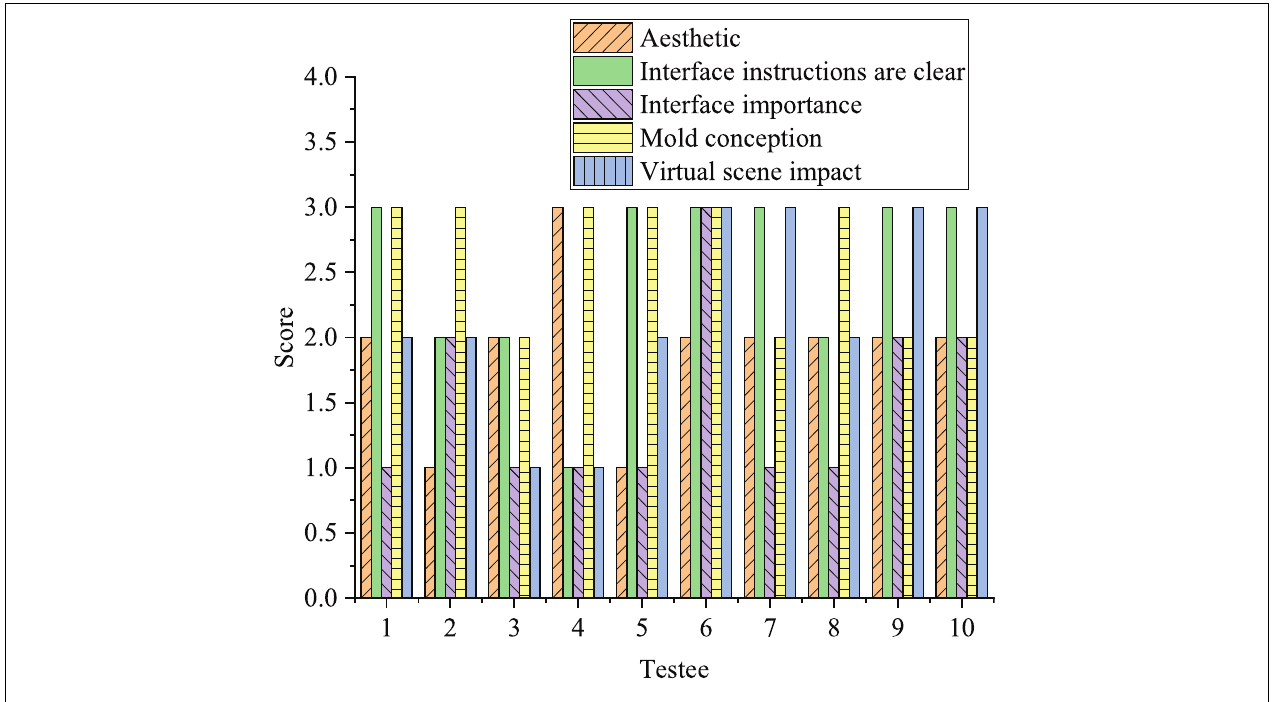
FIGURE 10 | Test results on the usability of VR-based Sand Table game.